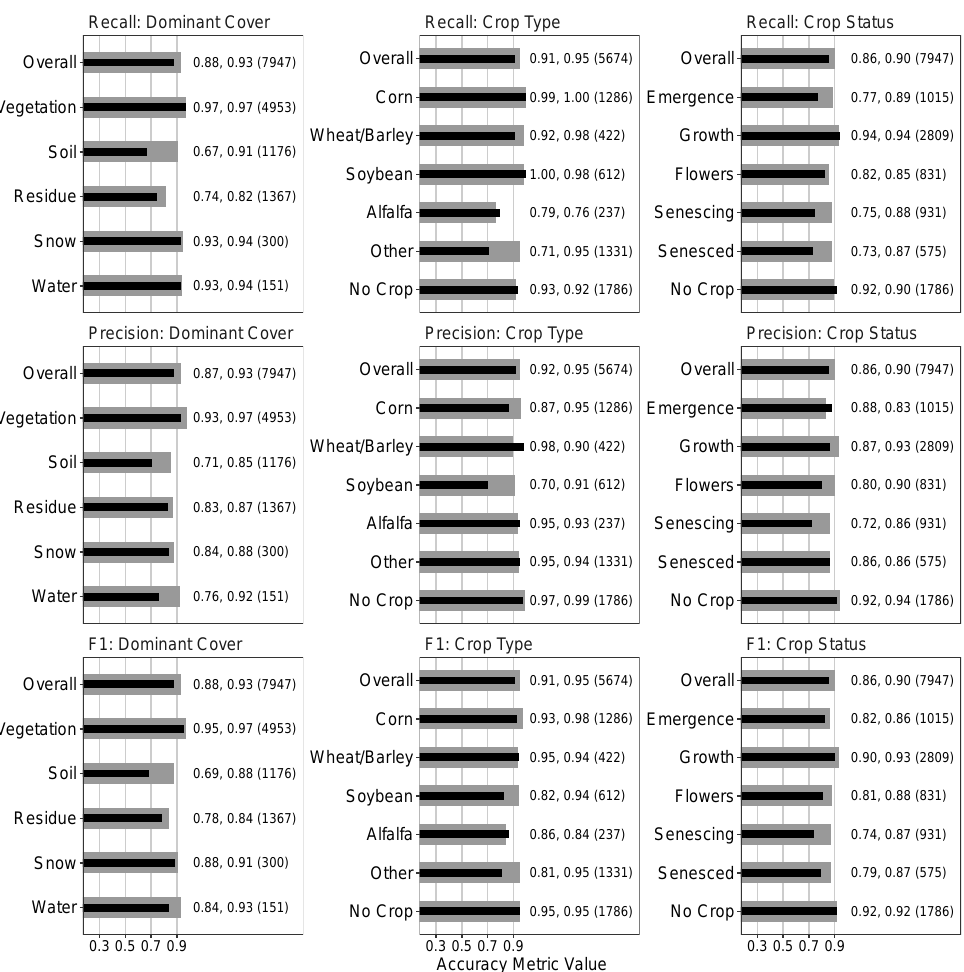
Figure 3. Accuracy metrics for the classifications after post-processing. The black and grey bars represent the validation and training datasets, respectively. The text indicates the respective metric value for validation, training, and class sample size in parentheses. The training and validation sample sizes are 80% and 20% of the total sample size, respectively. Overall indicates the average metric value for the respective category, weighted by sample size. All three metrics have a range of 0–1, where 1 equals a perfect prediction. Differences between this and Figure 2 is the exclusion of the blurry and unknown plant classes, with total sample sizes reflecting